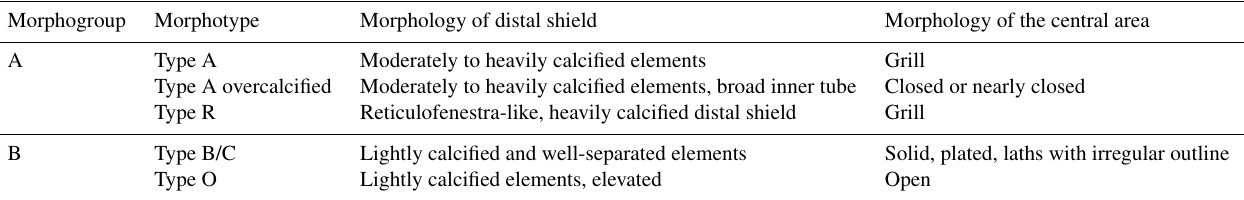
Table 1. Identified Emiliania huxleyi morphotypes and classification summary based on Young et al. (2020), Hagino et al. (2011) and Saavedra-Pellitero et al. (2019). See Fig. 2 for example images for the respective morphotypes. Morphogroup Morphotype Morphology of distal shield Morphology of the central area Grill Moderately to heavily calcified elements, broad inner tube Closed or nearly closed Grill Lightly calcified and well-separated elements Solid, plated, laths with irregular outline